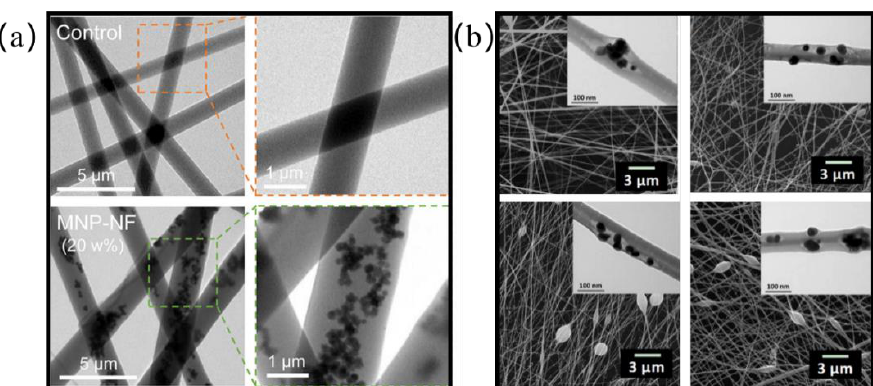
Figure 8. Existing forms of functional particles in fibers: ( a ) Fe 3 O 4 is uniformly dispersed in fibers Adapted with permission from [179]. Copyright, 2017 American Chemical Society; ( b ) SiO 2 particles are embedded on the surface of fibers Adapted with permission from [11]. Copyright, 2019 Elsevier.